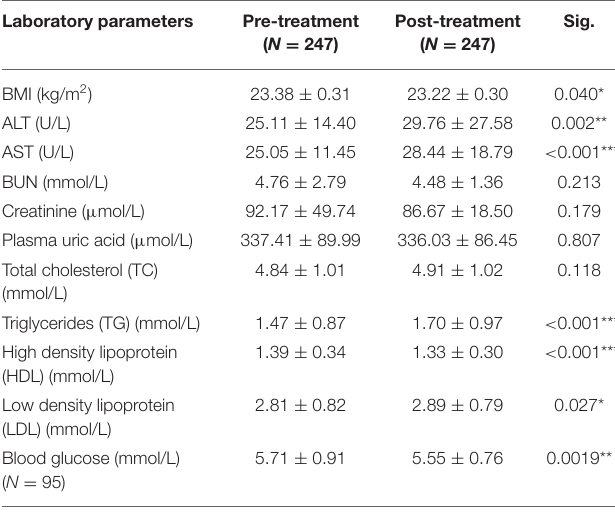
TABLE 2 | Fasting blood glucose and lipids levels change in patients with psoriasis after acitretin treatment for 8 weeks. Laboratory parameters